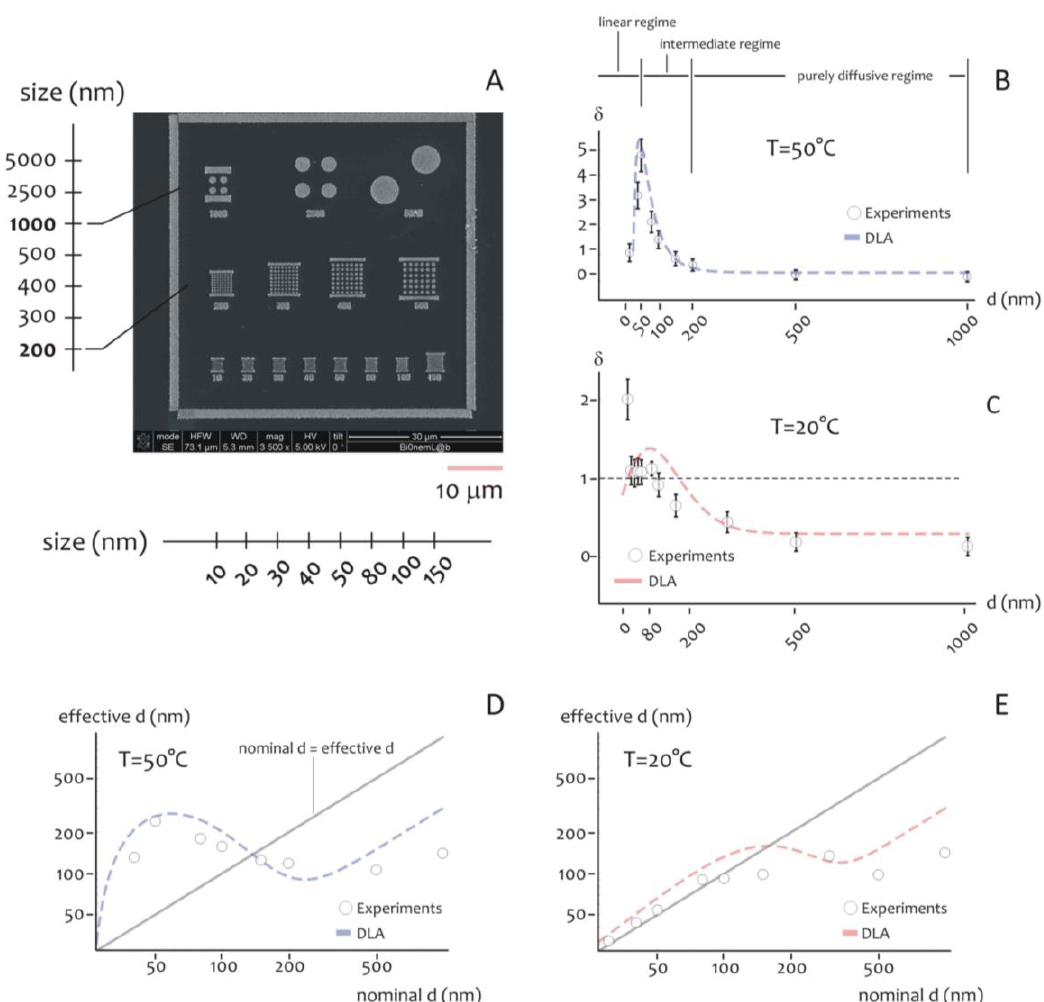
Figure 4. For analyzing the effect of pattern size on the characteristic of the nano-particles aggregates, we realized different lithographies, in which the size d of the patterns was varied from d = 10 nm, to d = 5,000 nm ( A ). The measured packing factor is reported in ( B ) as a function of pattern size d for fixed temperature ( T = 50 °C) and time of deposition ( t = 20 s). You may notice in the diagram three distinct regions, which correspond to different regimes of deposition. In ( C ), the packing factor is reported for T = 20 °C, the transition of the maximum towards larger values of d , can be explained making use of the classical nucleation theory (CNT). The information contained in ( B , C ) is organized differently as in ( D , E ), where the effective particle size obtained upon growth is reported as a function of the pattern size, that is, the nominal size of the nanoparticle. The diagram shows the effective particle diameter for a fixed pattern size, and has particular relevance for the nano-fabrication